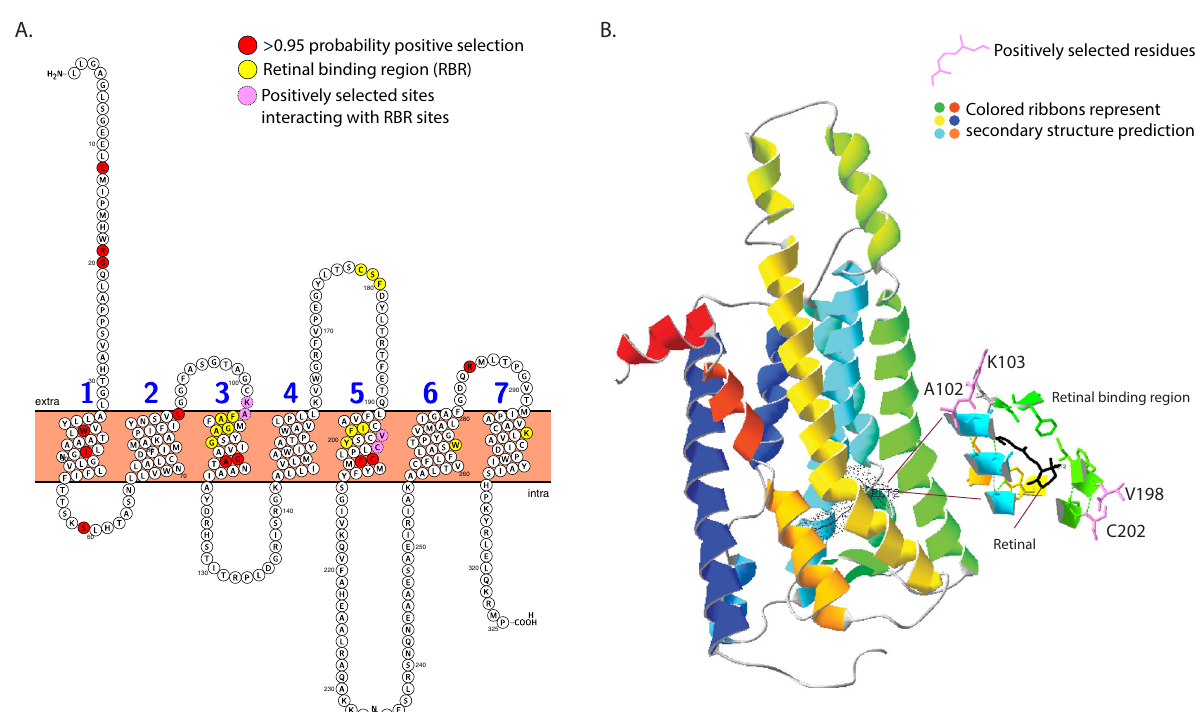
Fig. 3 Opsin structural prediction with retinal binding sites, sites with higher dN/dS (positively selection) and putative tuning sites, the subset that interacts with both. A UV-opsin PHOBIUS transmembrane prediction. Opsins sites with higher dN/dS rates and amino acids close to (< = 4 Å) retinal, which form the retinal binding region (RBR) have been marked. B UV-opsin model made using squid rhodopsin as the template. Retinal is marked, secondary structure prediction of alpha helices are shown in different colors and the expanded view shows the positively selected sites that can interact (< = 2 Å) with the retinal binding sites. Protein models used to get these metrics can be found at ref. 38 . Sites under positive selection are highlighted in red, sites in the retinal binding region in yellow and positively selected sites that are capable of interacting with the retinal binding sites in pink, identifying likely candidates for opsin tuning ( A ). Other positively selected are located within the transmembrane region and could be indirectly involved in opsin tuning ( B